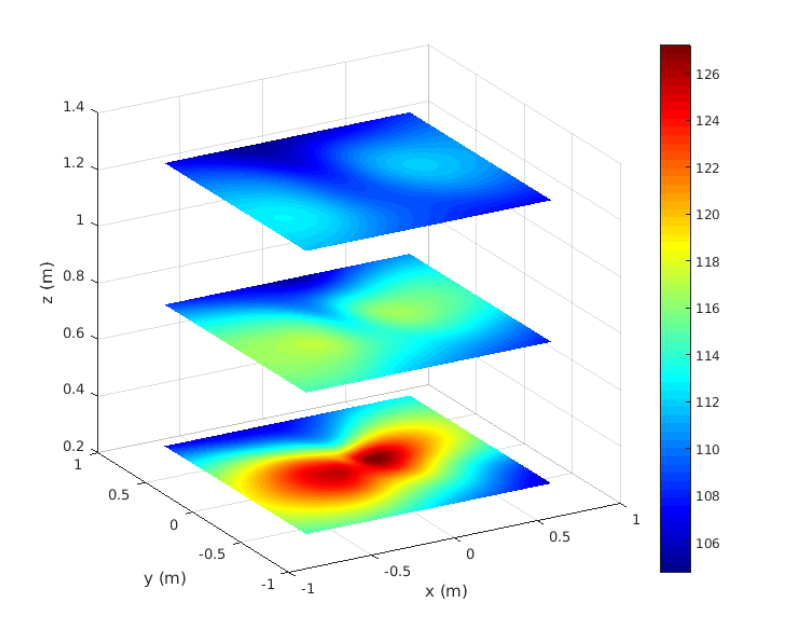
Figure 3. Acoustic patterns in dB for the steady state vibration regime (for t > 1 s) on different horizontal planes at 0.25 m, 0.75 m and 1.25 m.